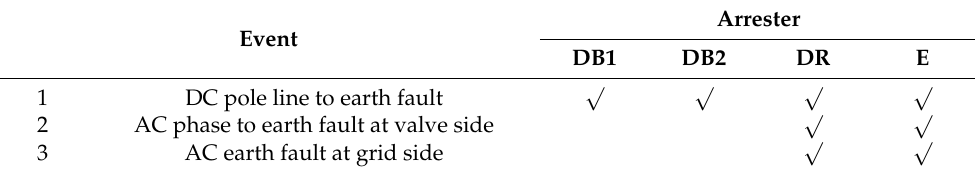
Table 8. Events for switching overvoltage.